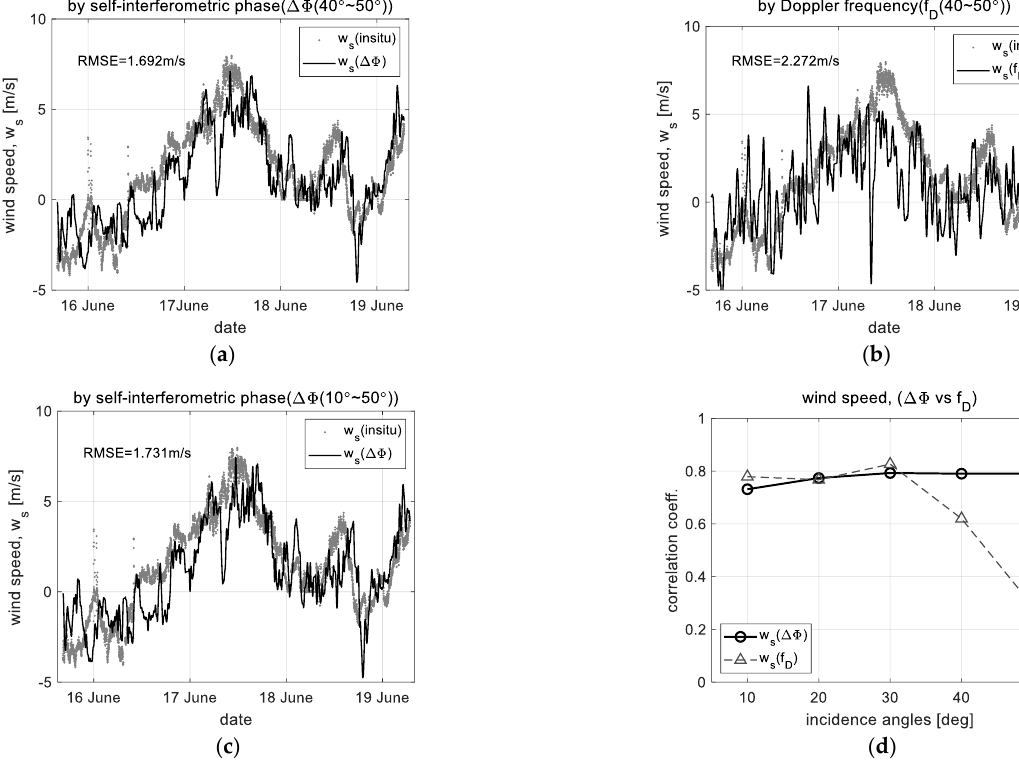
Figure 11. Observation results for wind speed( w s ): ( a , b ) the wind speed retrieved by the proposed- and existing method at the unstable region (40 ° ~50 ° ), ( c ) the observation result of wind speed by the proposed method, and ( d ) the comparison of correlation coefficients ( ΔΦ vs. f D ).